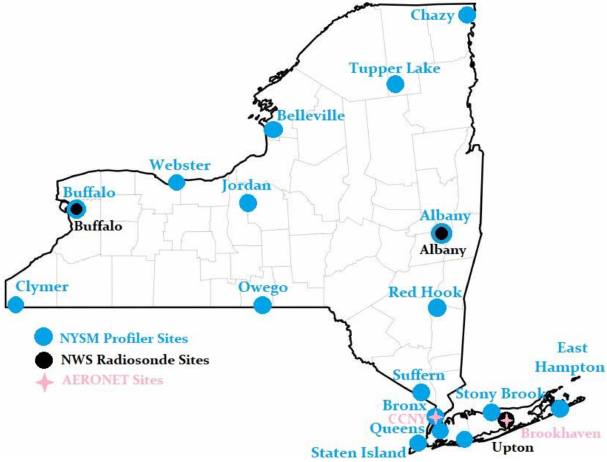
Figure 1. A map of New York State Mesonet Profiler Network, NWS radiosonde, and AERONET